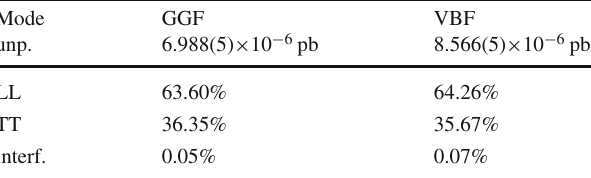
Table 2 Total cross-sections and polarization fractions in the LEP setup. Numerical errors for the unpolarized signals are shown in paren-